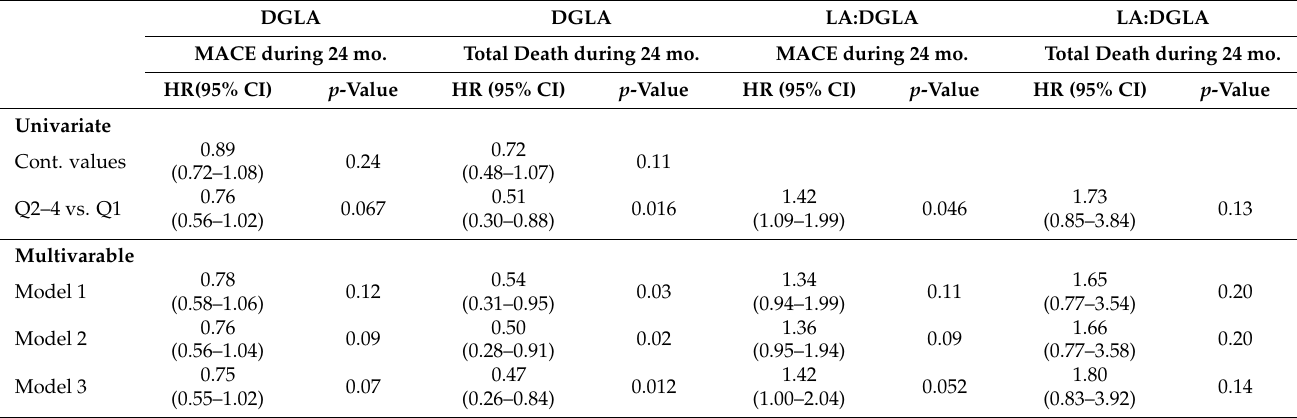
Table 4. Univariate and Multivariable Cox regression model applying continuous values and comparison of Quartiles 2–4 (Q2–4) vs. Q1. DGLA